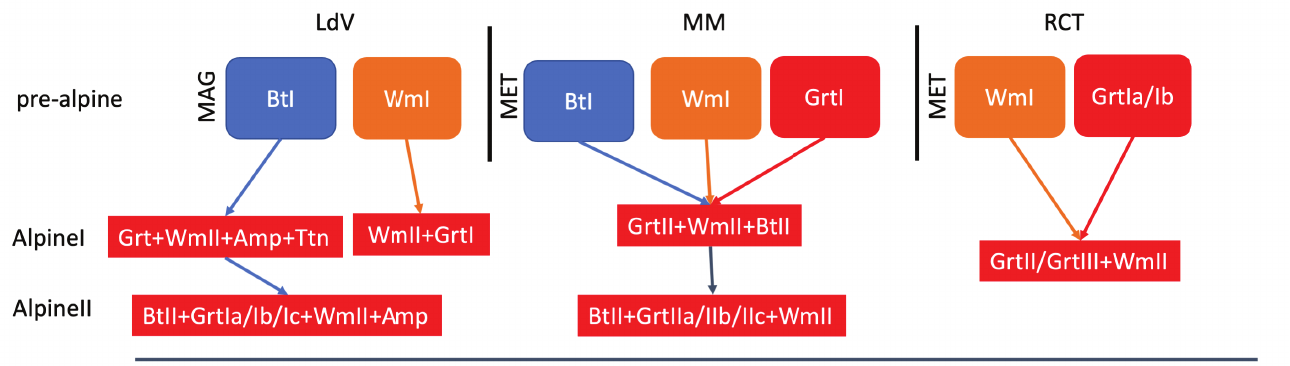
Figure 11. Schematisation of pre-Alpine mineralogical assemblages and subsequent Alpine development of mineralogical associations for the three investigated